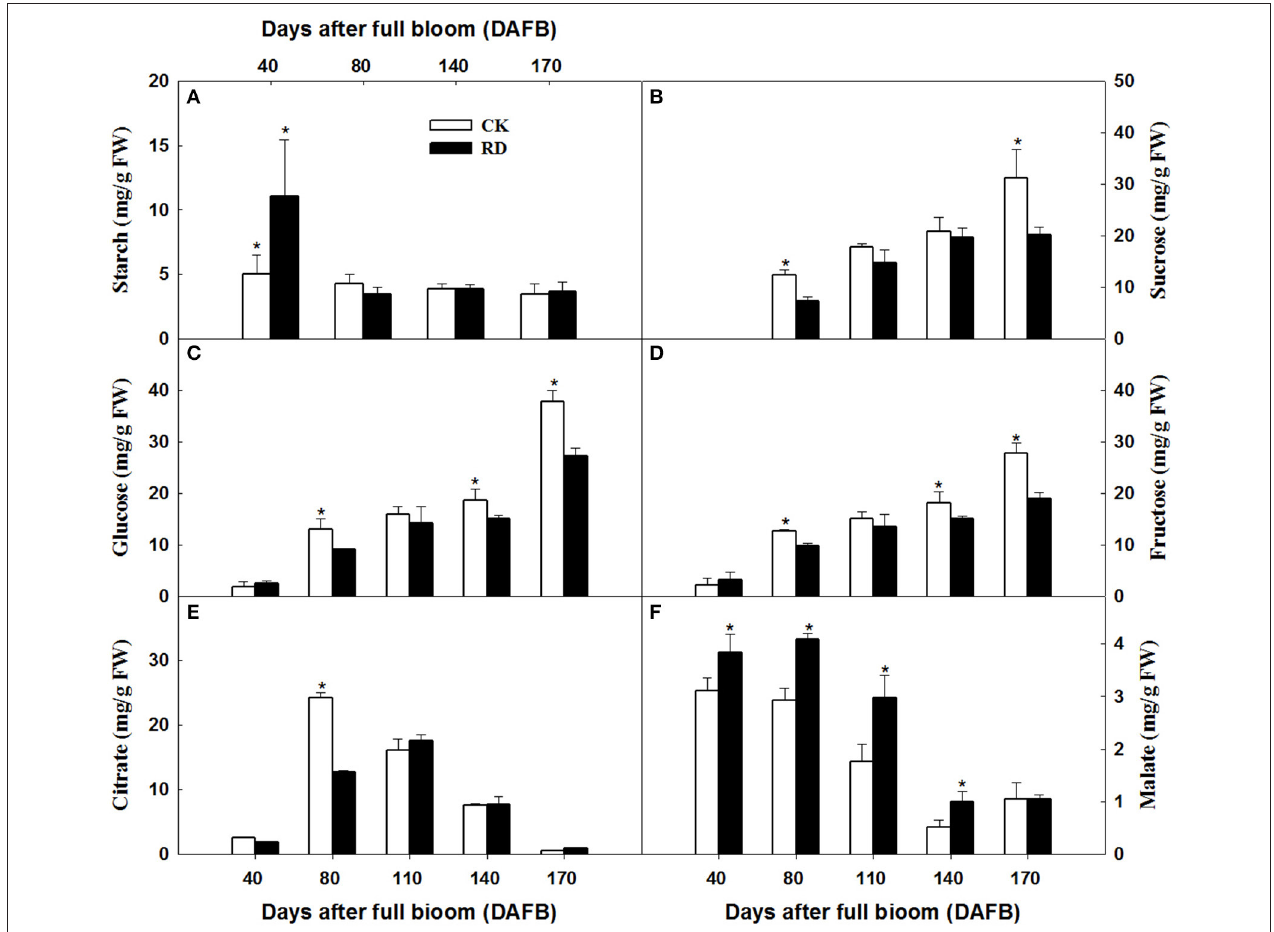
FIGURE 6 | Starch (A) , sucrose (B) , glucose (C) , fructose (D) , citrate (E) , and malate (F) accumulation in CK and RD peel during fruit development. Asterisk means significant difference at P <